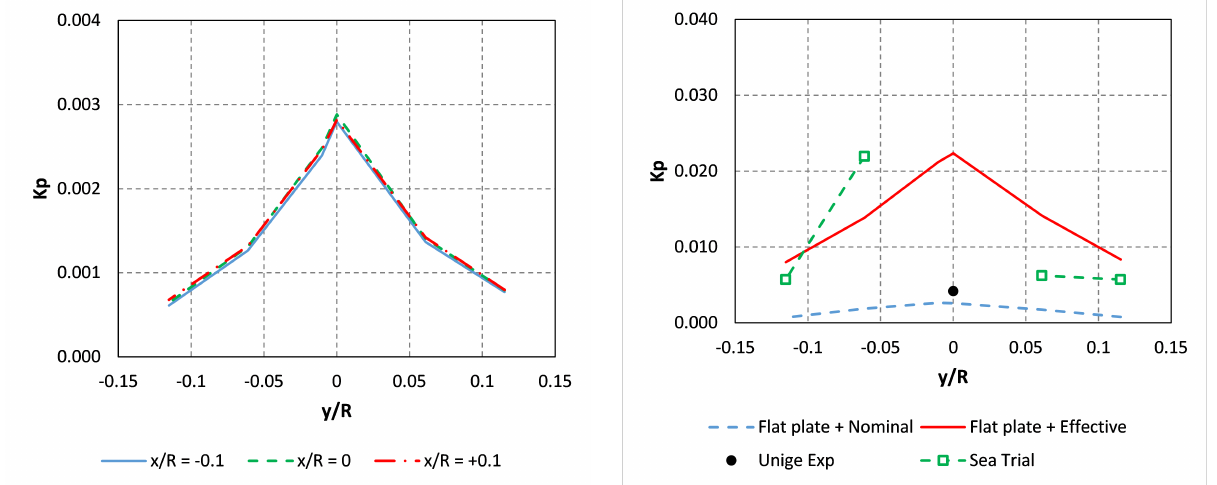
Figure A.7: Comparison between predicted and measured pressure pulses (second harmonic) in cavitating condition on the transversal section in correspondence of the propeller disk.